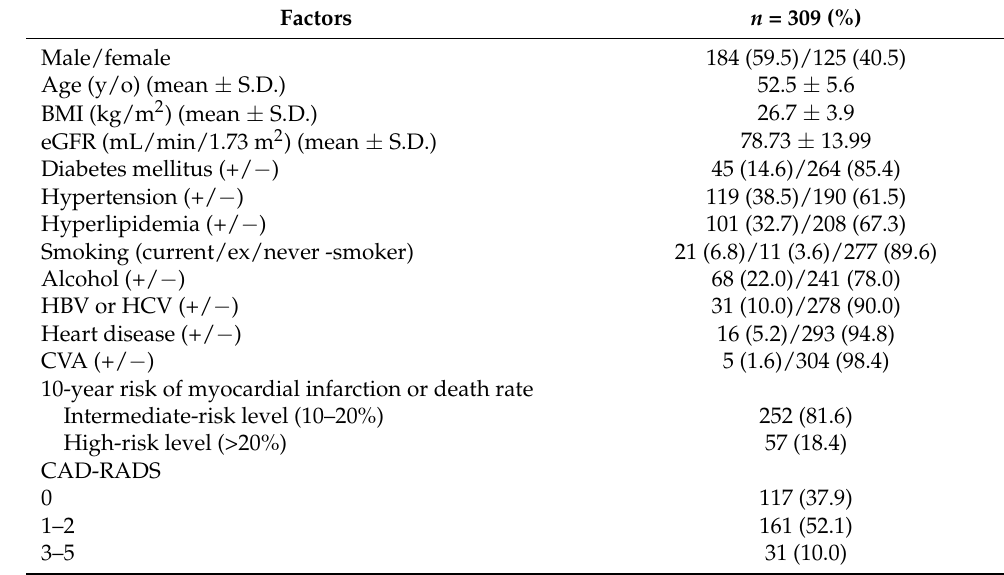
Table 1. Baseline data of 309 employees undergoing coronary computed tomography